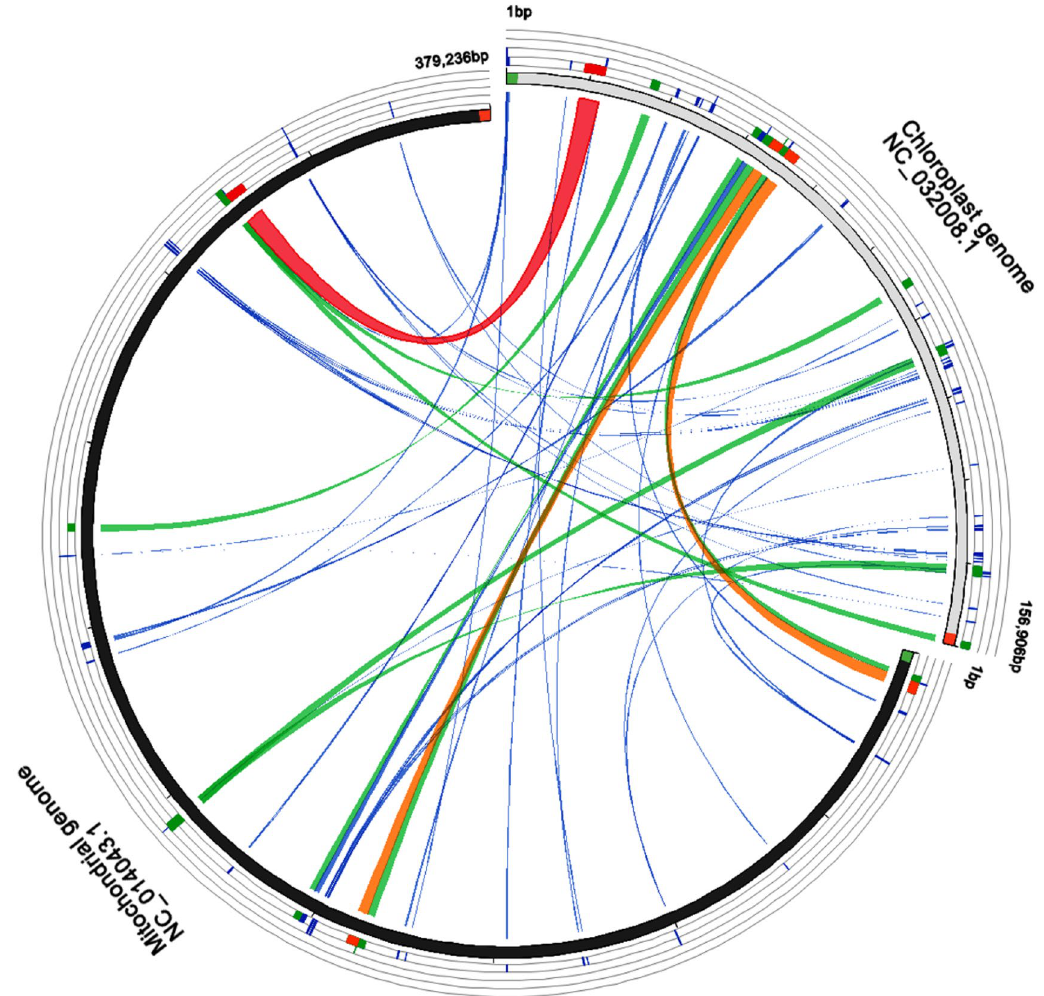
Figure 1. The transfer of sequences from chloroplast to mitochondrial genomes in C. lanatus.